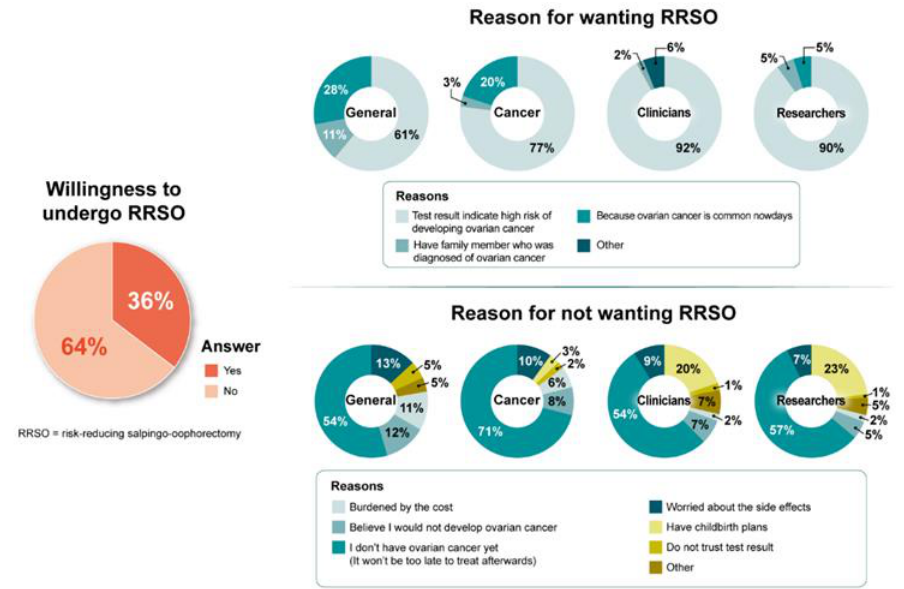
Figure 2. Intent to undergo risk-reducing salpingo-oophorectomy and its reasons by respondent type. Reasons reported by those expressing the intent to undergo RRM included “test re- sults indicated being at high risk of developing breast cancer” (67%), “because breast can- cer is common nowadays” (28%), and “family history of breast cancer” (5%). “The fact t hat I do not have breast cancer yet” (66%) was the most frequently reported reason among individuals not willing to undergo RRM (Figure 3).